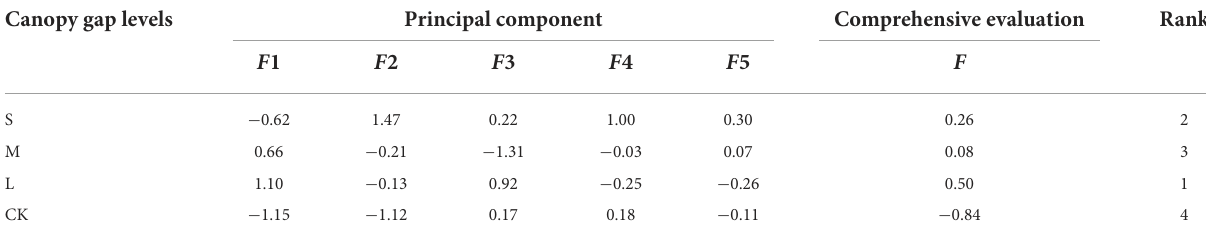
TABLE 3 Comprehensive appraisal value and sequencing of forest